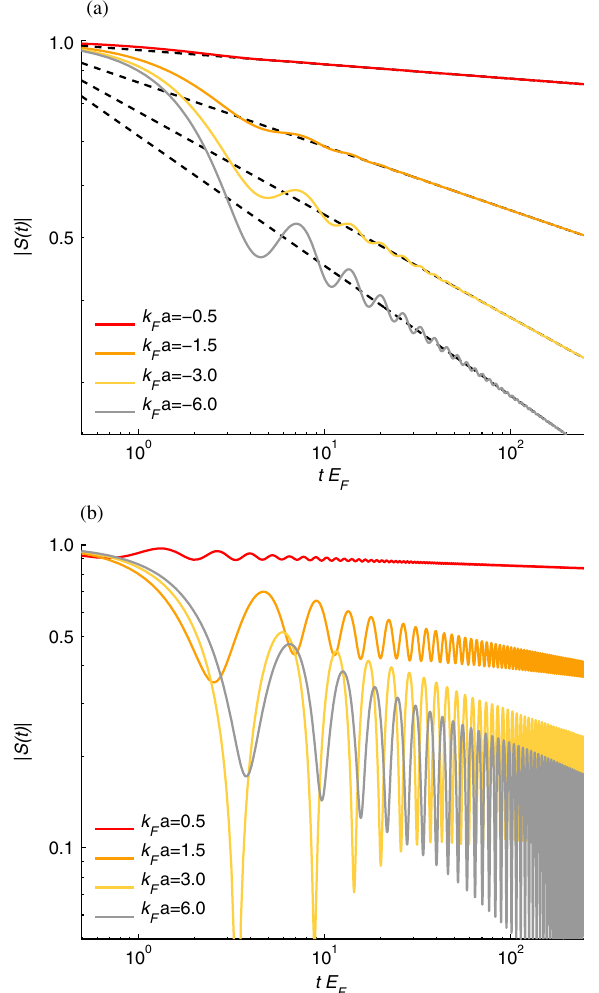
FIG. 4. Universal overlap function j S ð t Þj , which can be mea- sured in the Ramsey interferometry experiment, is shown for different values of the scattering length a ; see legend. Panel (a) shows j S ð t Þj for the case a < 0 , when the impurity potential does not create a bound state. The dashed lines are power-law fits, Eq. (12), at long times. At intermediate times, oscillations coming from exciting an extra hole near the bottom of the band arevisible.